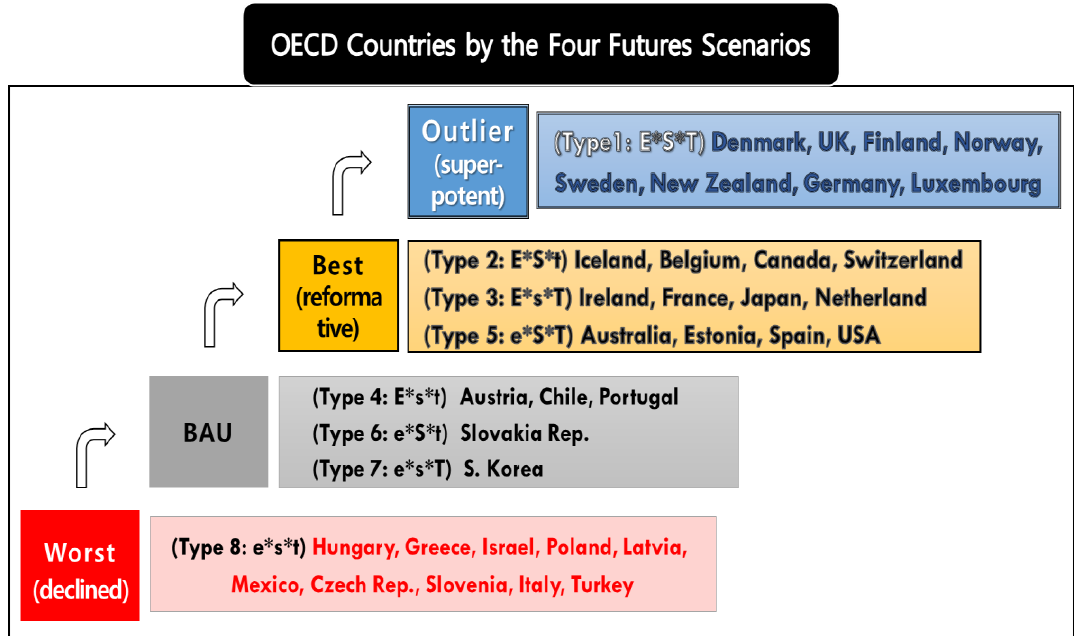
Figure 4. Futures scenarios results of energy transition in OECD countries.